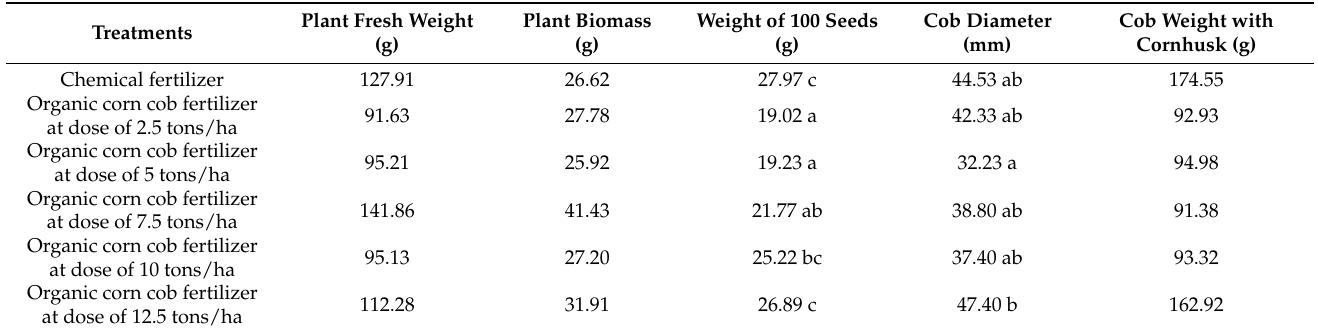
Table 4. The role of various doses of corn cob compost on corn